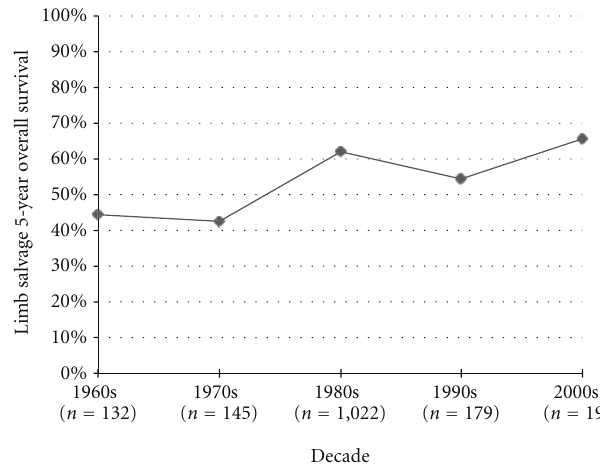
Figure 10: Osteosarcoma 5-year overall survival among limb salvage